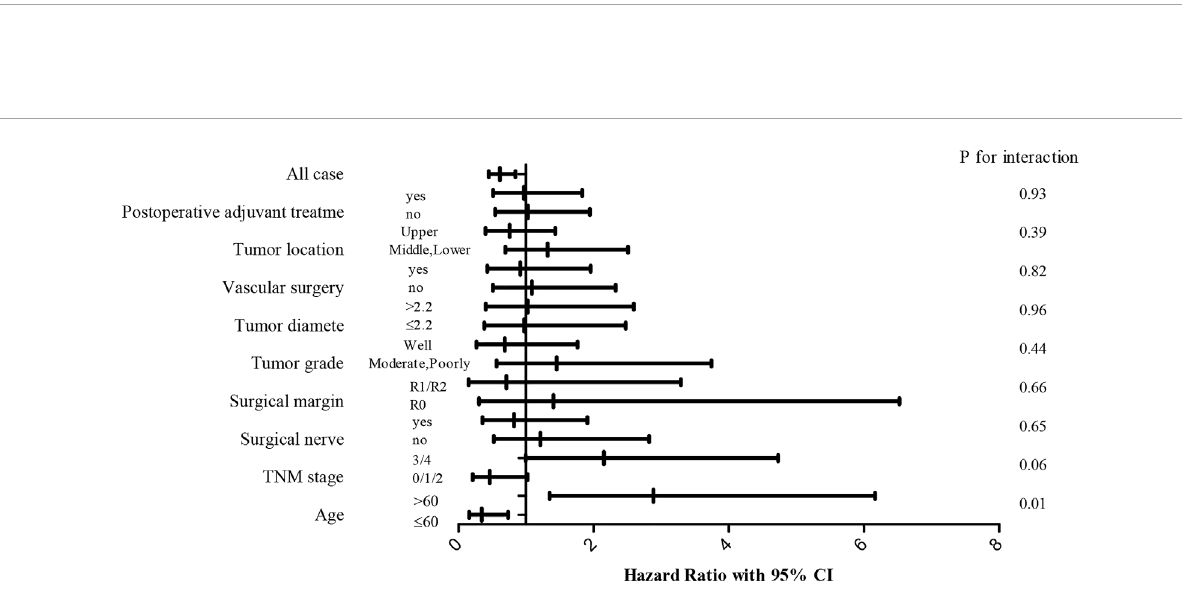
FIGURE 4 Forest plots of hazard ratio (HR) with 95% CI for each of the stated variables for the female